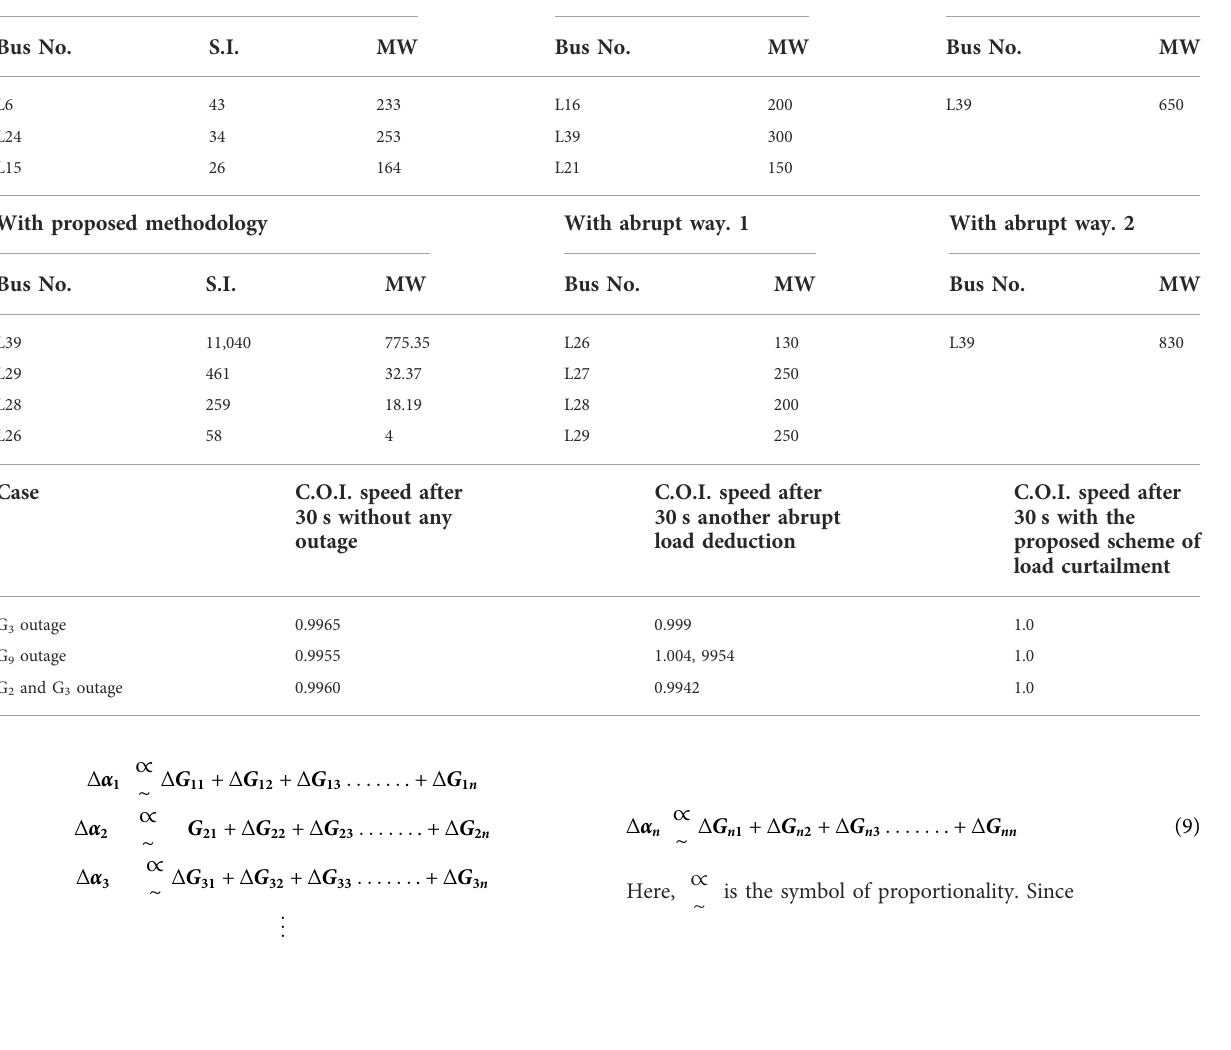
TABLE 2 (A) Active power deduction in case of G 3 outage. (B) Active power deduction in G 9 outage condition. (C) C.O.I steady-state value in different cases. With proposed methodology Abrubt way. 1 Abrubt way. 2 Bus No.